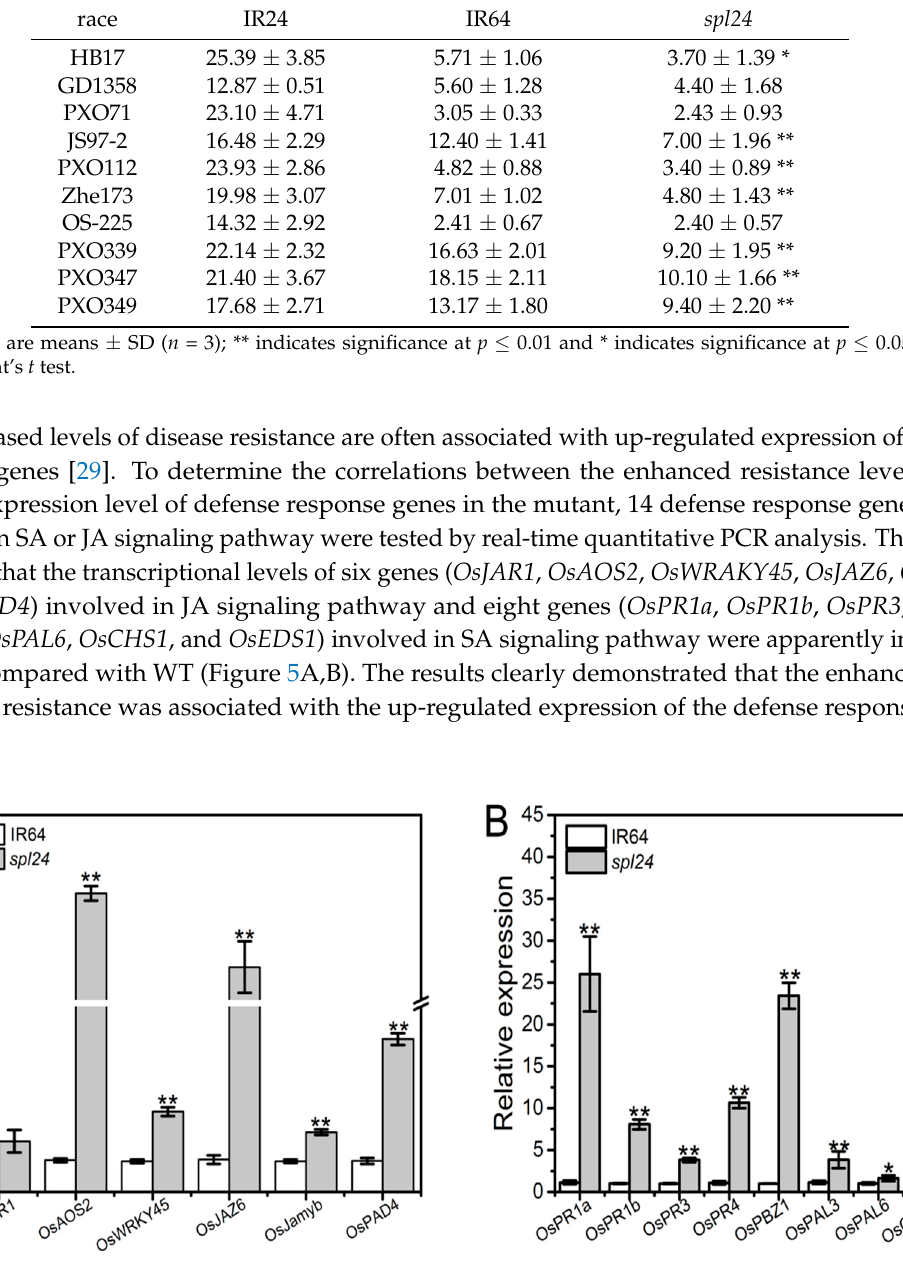
Table 2. Evaluation of disease resistance to Xanthomonas oryzae pv. oryzae . Lesion length (cm)